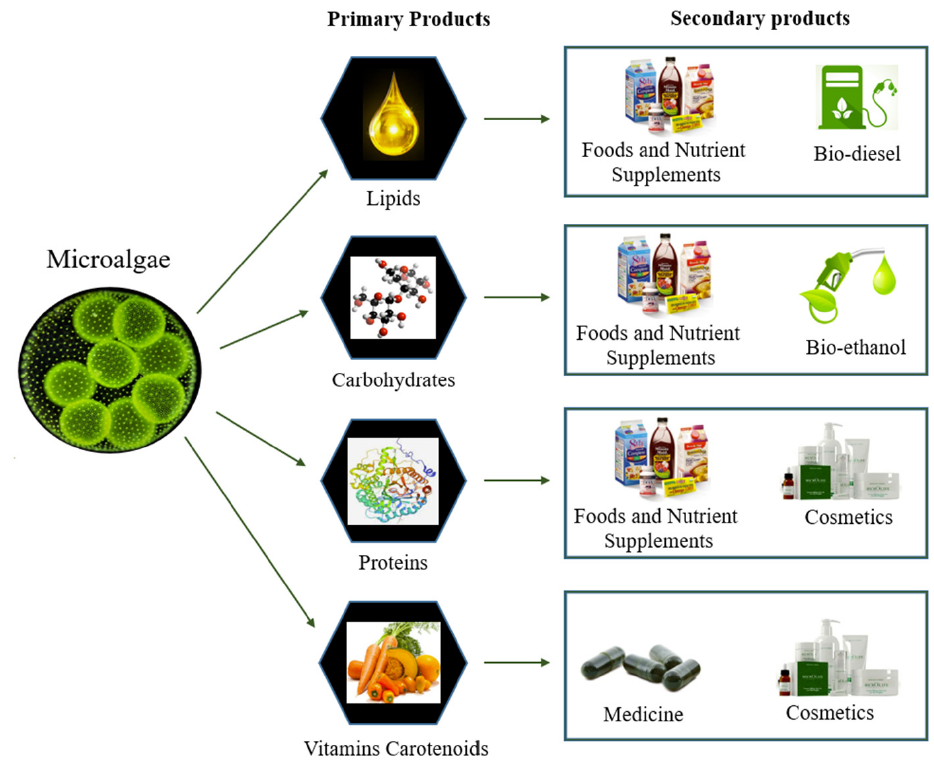
Figure 4. Primary components that can be extracted from microalgae and their secondary prod- ucts.